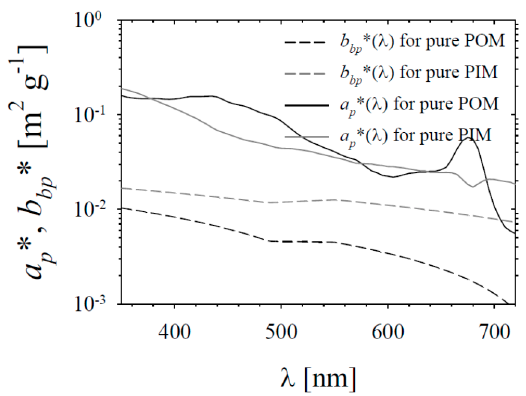
Figure 3. Assumed spectra of mass-specific absorption and backscattering coefficients, a p * and b bp *, for pure particulate organic matter (POM) and particulate inorganic matter (PIM) fractions, used by the simple water colour model adopted here to represent different conditions in the Baltic Sea (model A).